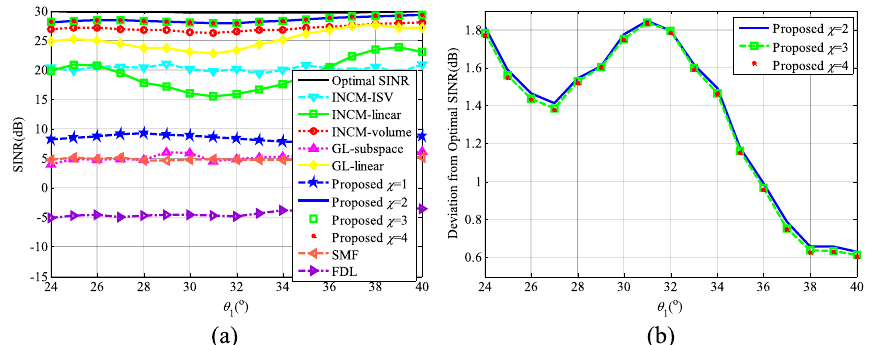
Fig. 10 Comparison of SINR for the last scenario. a SINR versus θ 1 . b Deviation from the optimal SINR against